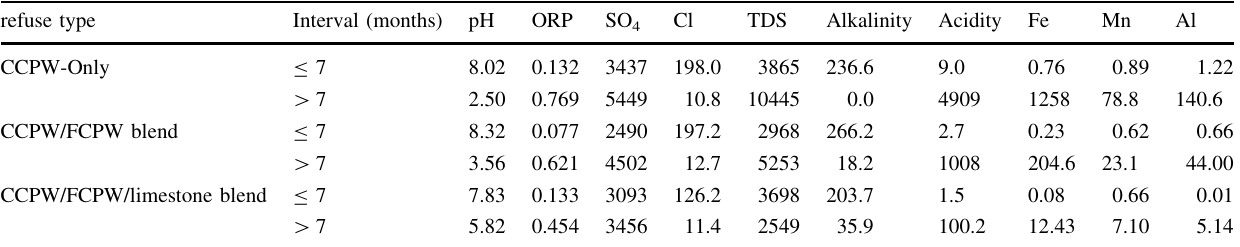
Fig. 3 Field kinetic test columns (left); photograph of field test site (right)